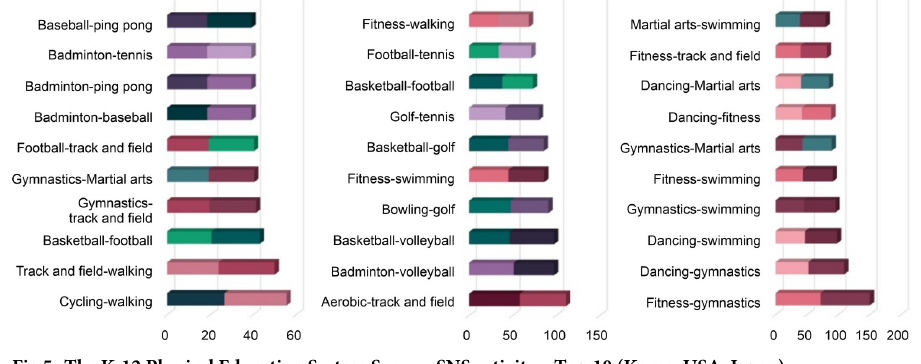
Fig 5. The K-12 Physical Education System Survey, SNS activity—Top 10 (Korea, USA, Japan).